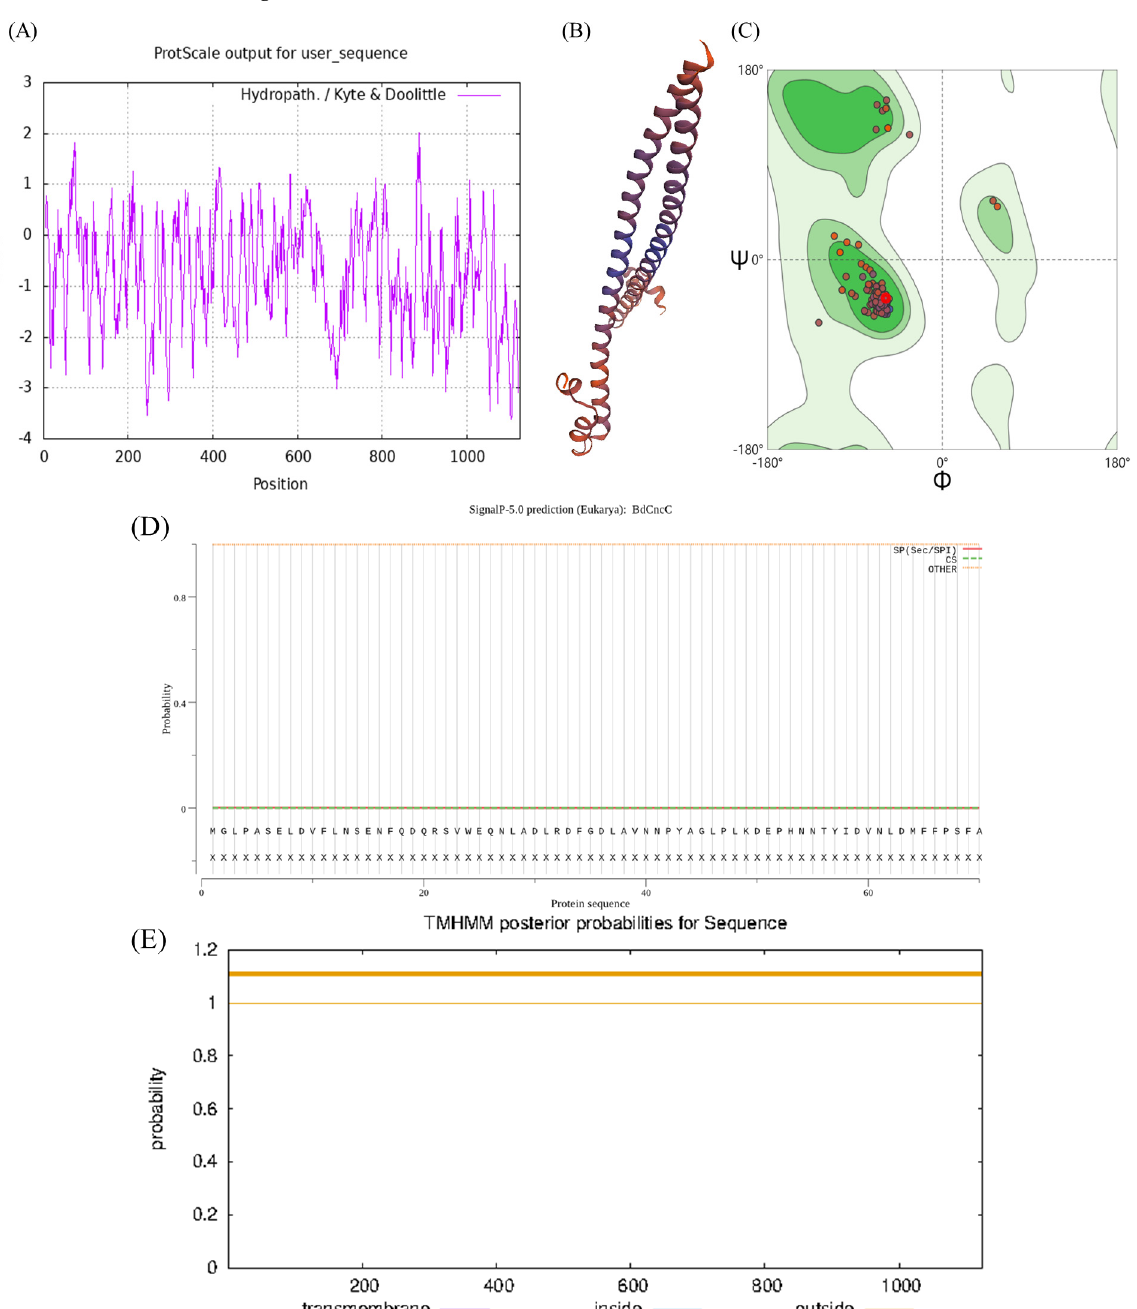
Figure 2. Domain analysis of BdCncC . ( A ) Hydrophobicity analysis; ( B ) three − dimensional structural model; ( C ) Ramachandran plots; ( D ) predicted signal peptide prediction results; ( E ) prediction of transmembrane domain structures.